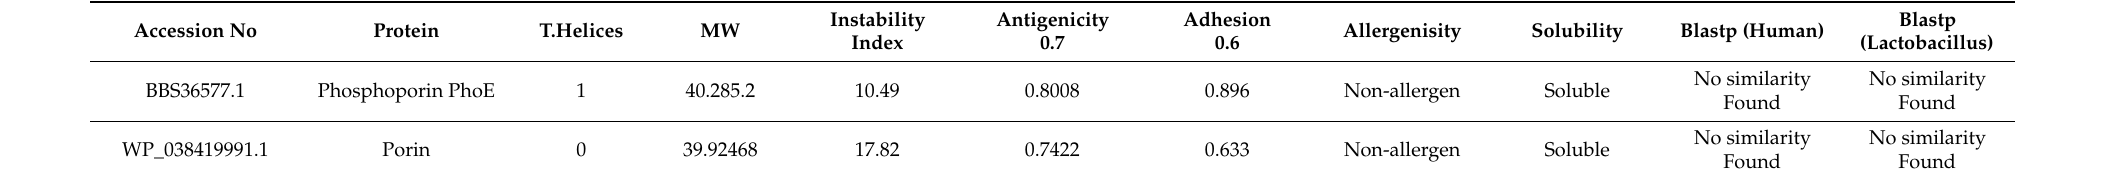
Table 1. Properties of the proteins used for the prediction of the immunodominant epitopes.